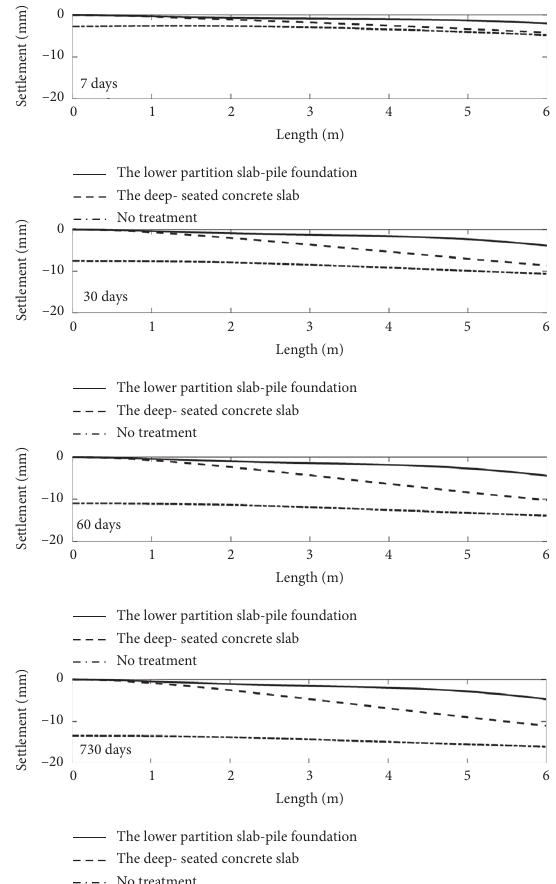
Figure 12: Comparison of treatment and disposal effects of different treatment